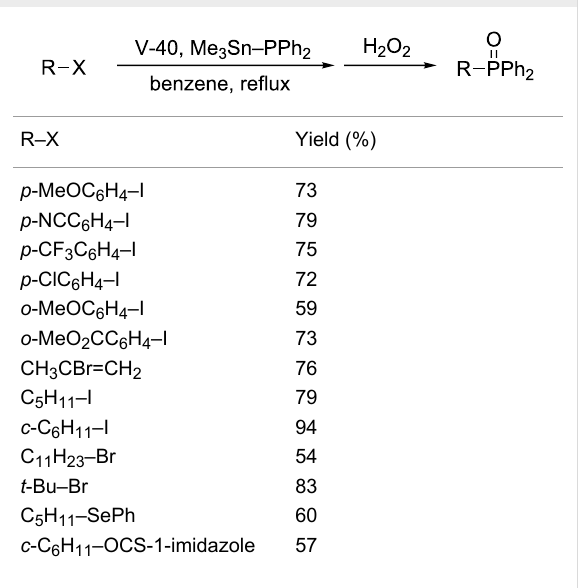
Table 8: Radical phosphination with Me 3 Sn–PPh 2